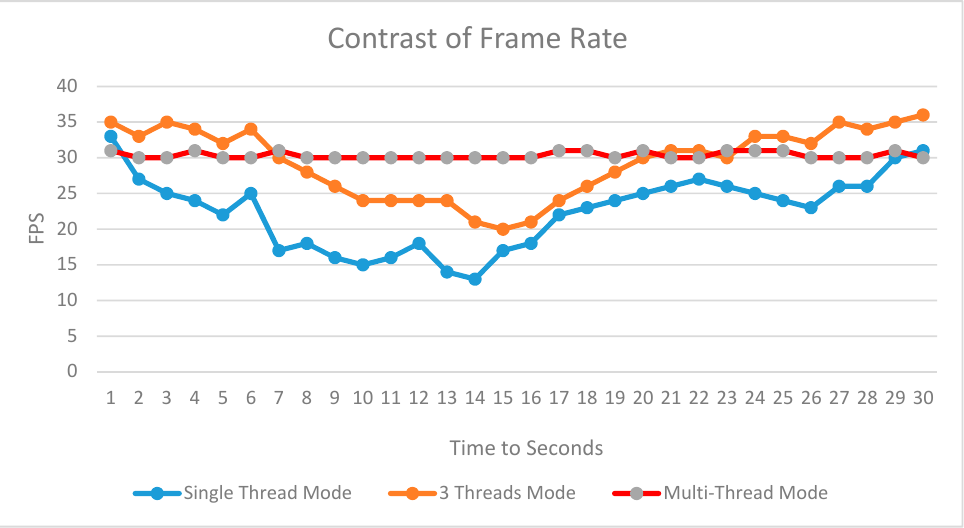
Figure 6. Comparison of the frames per second (FPS) of thread settings for pipeline tasks.